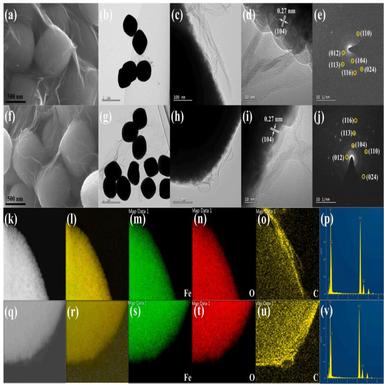
(a, f) FE-SEM, (b, g) low-magnification TEM, (c, h) high-magnification TEM, (d, i) HRTEM, (e, i) SAED, (k-o, q-u) EDS color mapping, and (p, v) EDS spectra of α-Fe2O3@rGO-10 wt% and α-Fe2O3@rGO-20 wt% core@shell nanocubes, respectively. (For interpretation of the references to color in this figure legend, the reader is referred to the Web version of this article.)